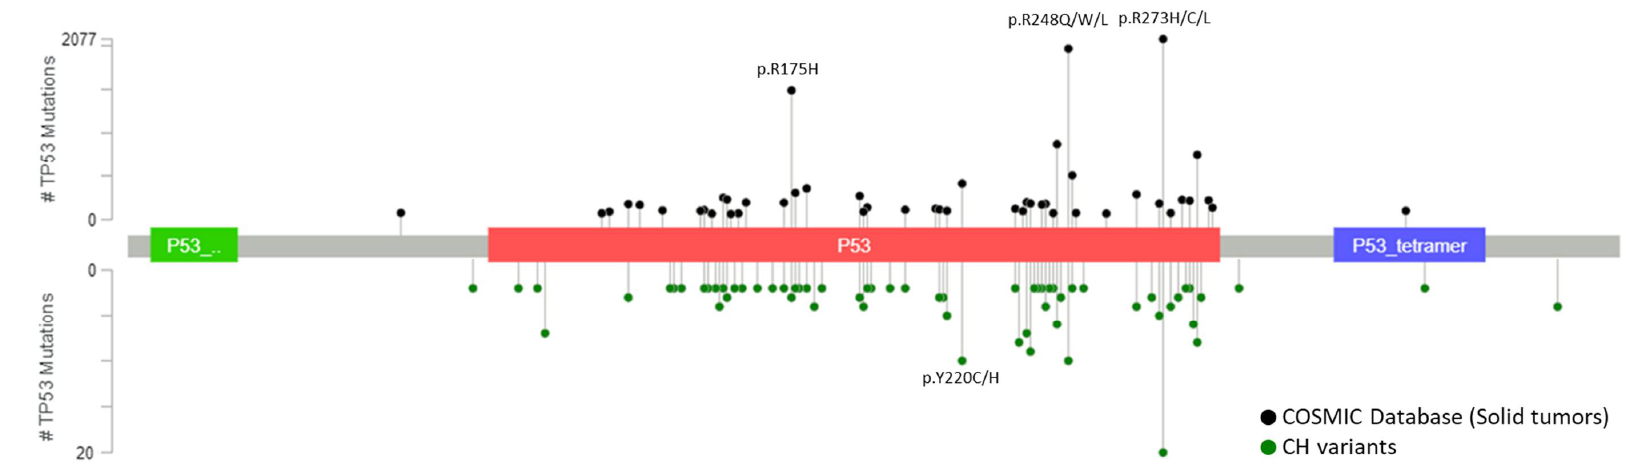
Figure 3. Most frequently detected TP53 variants from solid tumors and white blood cells. Positions and frequencies of most frequently detected TP53 mutations in solid tumors from COSMIC database (top plot) and in white blood cells from 14 published studies (bottom plot). All reported variants of TP53 from the COSMIC database were gathered and variants detected from hematopoietic and lymphoid neoplasms were filtered leaving only the variants detected from solid tumors. CH TP53 variants were similarly gathered from 14 reported studies (References [5,48–50,53,56,62,70–76]). Variants without genomic positions documented were further removed from the analysis leaving a total of 801 CH mutations across 657 different variants. All variants that were reported more than once across the 14 studies were used for the analysis and compared with the top 85 most frequently detected TP53 variants from solid tumors. Lollipop plots were generated using the MutationMapper from cBioPortal [83,84]